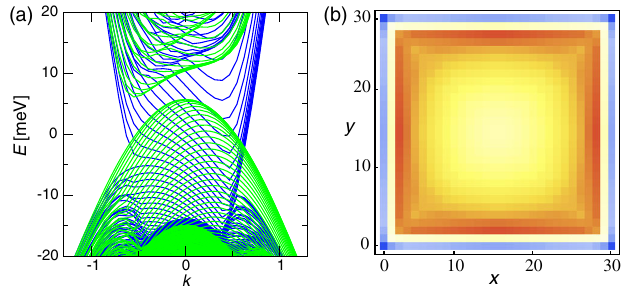
FIG. 10. Persistent currents in a Cd 3 As 2 nanowire under torsion and magnetic field. (a) Band-structure detail for spin-up (blue) and spin-down (green) sectors in a 30 × 30 lattice with B ¼ b ¼ 3 . 2 T and other parameters as in Fig. 9. (b) Calculated current density j for μ ¼ 0 , including contributions from both spin